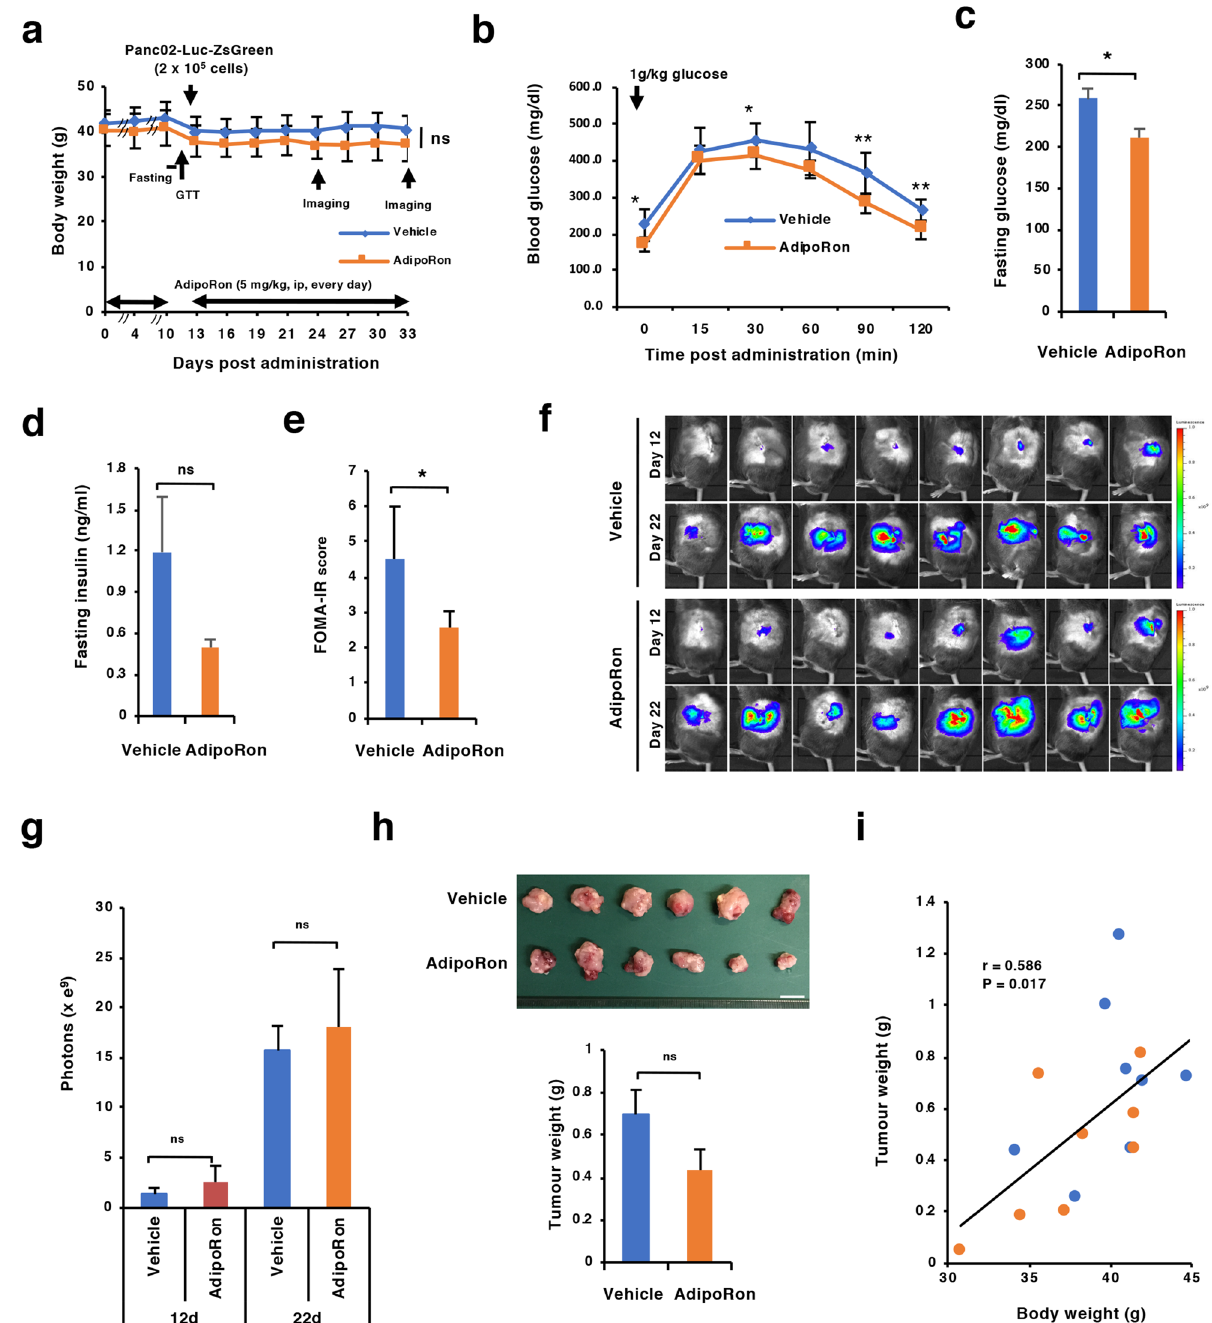
Figure 2. Effect of AdipoRon on orthotopic tumour growth in DIO mice maintained on an HFD. ( A ) Schedule of the experiments and monitoring of body weight. DIO mice were intraperitoneally administered 5 mg/ kg AdipoRon or vehicle every day for 10 days, and then the GTT and blood sampling were performed after overnight fasting. On day 11, Panc02-Luc-ZsGreen cells (2 × 10 5 cells in 50% Matrigel) were injected into the pancreas. From day 13, the mice were intraperitoneally administered 5 mg/kg AdipoRon or vehicle every day until day 30. On day 23 and day 33, in vivo bioluminescent imaging was performed. ( B ) GTT performed on day 11 (n = 5 mice for each group). ( C ) Fasting glucose level (n = 5 mice for each group). Blood was collected on day 11 after fasting. ( D ) Fasting insulin level. Blood was collected on day 11 after fasting (n = 5 mice for each group). ( E ) HOMA-IR score calculated from the fasting glucose level and fasting insulin level in blood. ( F ) In vivo bioluminescent images. Orthotopic tumour growth in the vehicle- and AdipoRon-administered mice (n = 8 mice for each group) was assessed on day 23 (12 days after tumour implantation) and day 22 (22 days after tumour implantation). ( G ) Tumour growth on day 12 and day 22 represented by photons. Photons from animals’ whole bodies were imaged using the IVIS imaging system. ( H ) Tumours and tumour weight. Bar 1 cm. ( I ) Correlation between body weight and tumour weight. Blue and orange circles represent individual mice in the LFD and HFD groups, respectively. *P < 0.05, **P < 0.01, ns, not